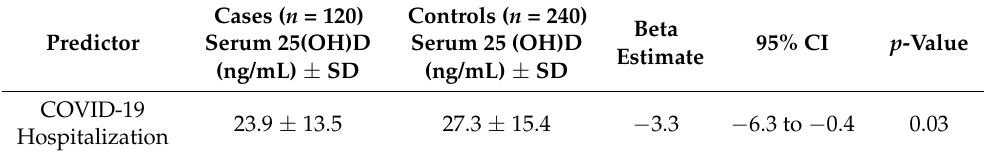
Table 6. Association of serum 25-hydroxy vitamin D with severe COVID-19